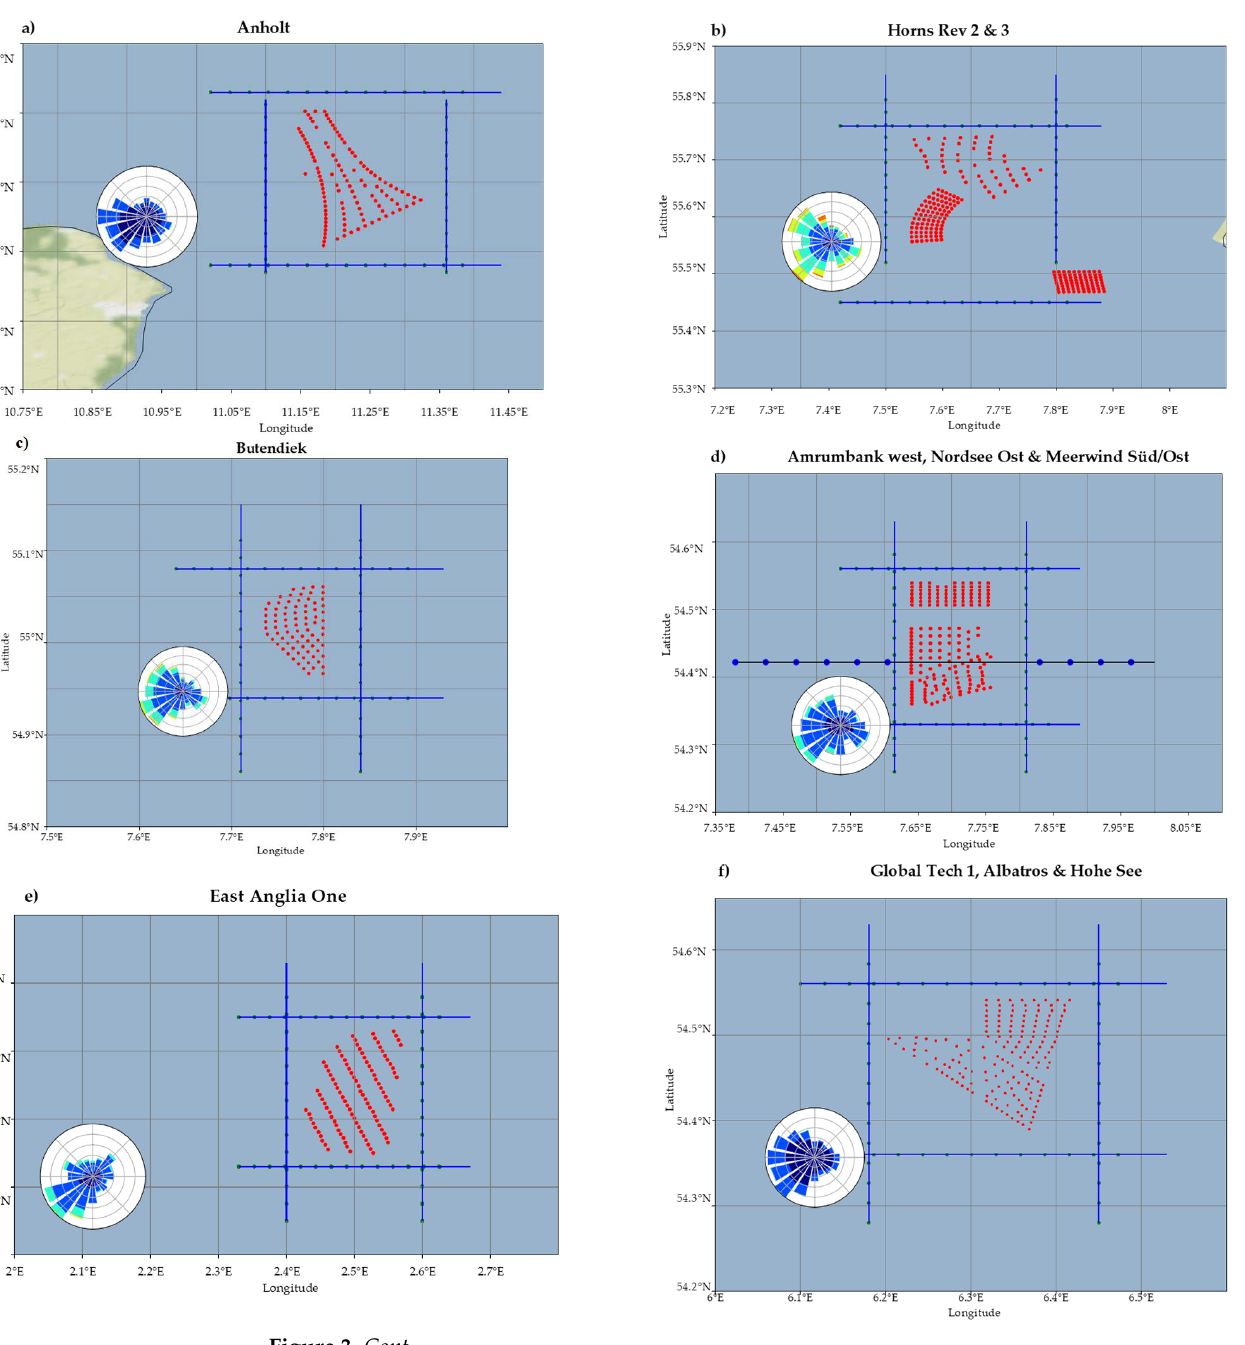
Figure 3. Selected OWFs and clusters: ( a ) Anholt, ( b ) Horns Rev 2 and 3, ( c ) Butendiek, ( d ) Am- rumbank West, Nordesee Ost, and Meerwind Süd/Ost, ( e ) East Anglia One, ( f ) Global Tech 1, Alba- tros, and Hohe See, ( g ) Greater Gabbard and Galloper, and ( h ) Hornsea Project One. The blue lines are the transect lines around the OWFs and clusters, and the green points are the transect points and distributed uniformly along the transect lines. The red points are the positions of wind turbines, and the wind roses represent the wind direction taken from all available scenes at the transect point P7 at the west transect line. Before calculating the mean wind speeds of rectangular bins of transect lines, our set of SAR scenes in Table 1 is filtered according to the following criteria: